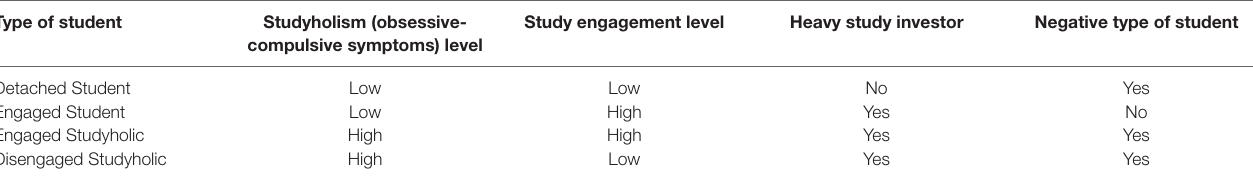
TABLE 1 | Loscalzo and Giannini’s (2017) four types of